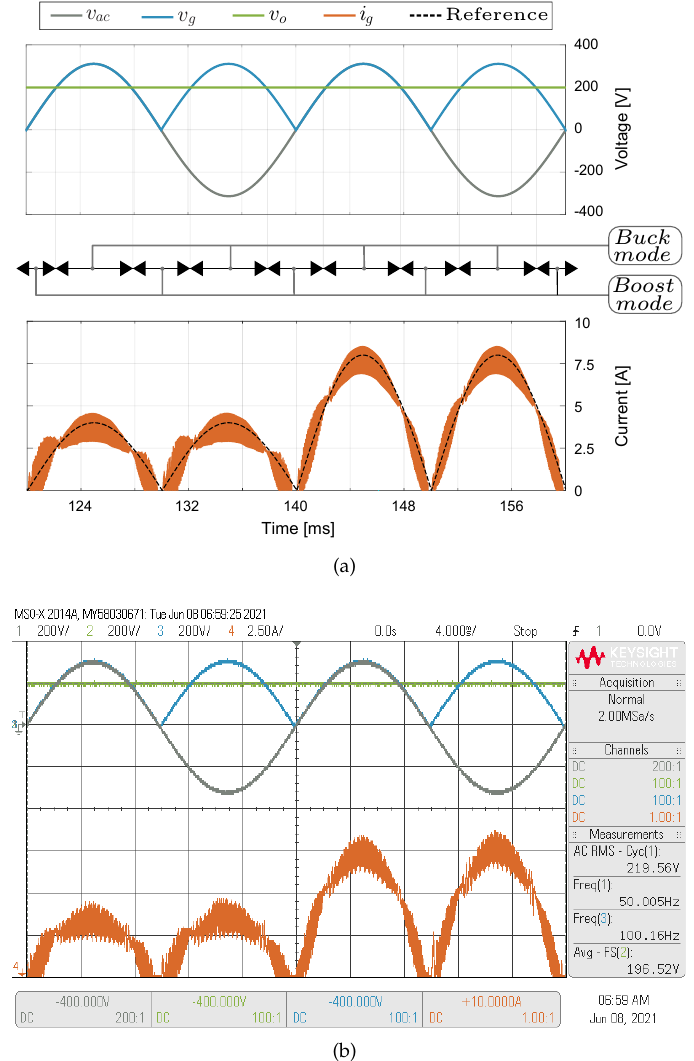
Figure 9. Simulated ( a ) and experimental ( b ) dynamic behavior of the predictive digital current input control when the reference i ref changes from 4 A to 8 A with a fixed output voltage V o = 200 V. CH1: v ac (200 V/div), CH2: v o (200 V/div), CH3: v g (200 V/div), CH4: i g (2.5 A/div) and a time base of 4